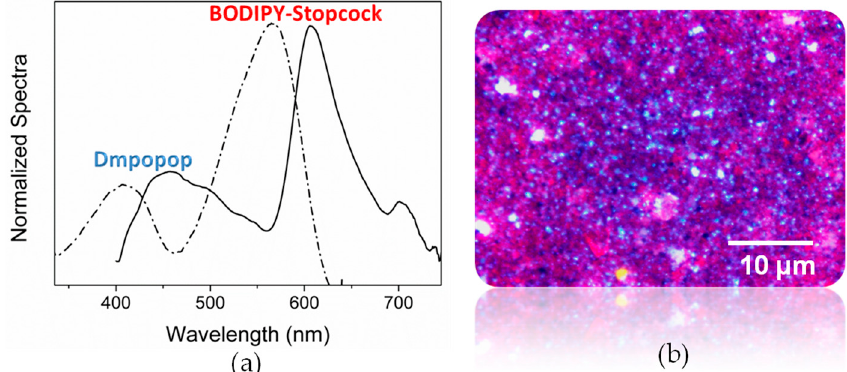
Figure 8. ( a ) Normalized excitation (emission measured at 660 nm, dashed line) and emission (excited at 350 nm, solid line) spectra of DMPOPOP enclose into the channels and BODIPY stopcock grafted in the disc-shaped LTL zeolite entrances; ( b ) Fluorescence microscopy image of the hybrid zeolite-dye system under 350/50-nm band-pass excitation and recording the emission with a 400-nm long-pass filter.